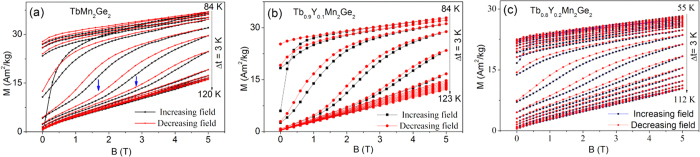
Curves of isothermal magnetization versus magnetic field at temperatures around Tc.(a) TbMn2Ge2, (b) Tb0.9Y0.1Mn2Ge2 and (c) Tb0.8Y0.2Mn2Ge2.